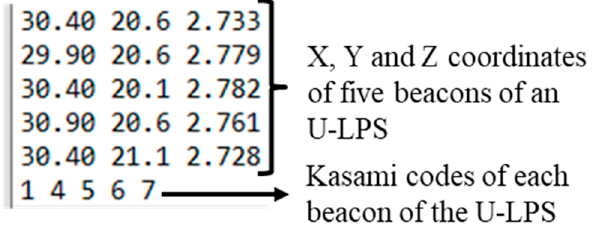
Figure 15. Example of plain text file for U-LPS configuration.